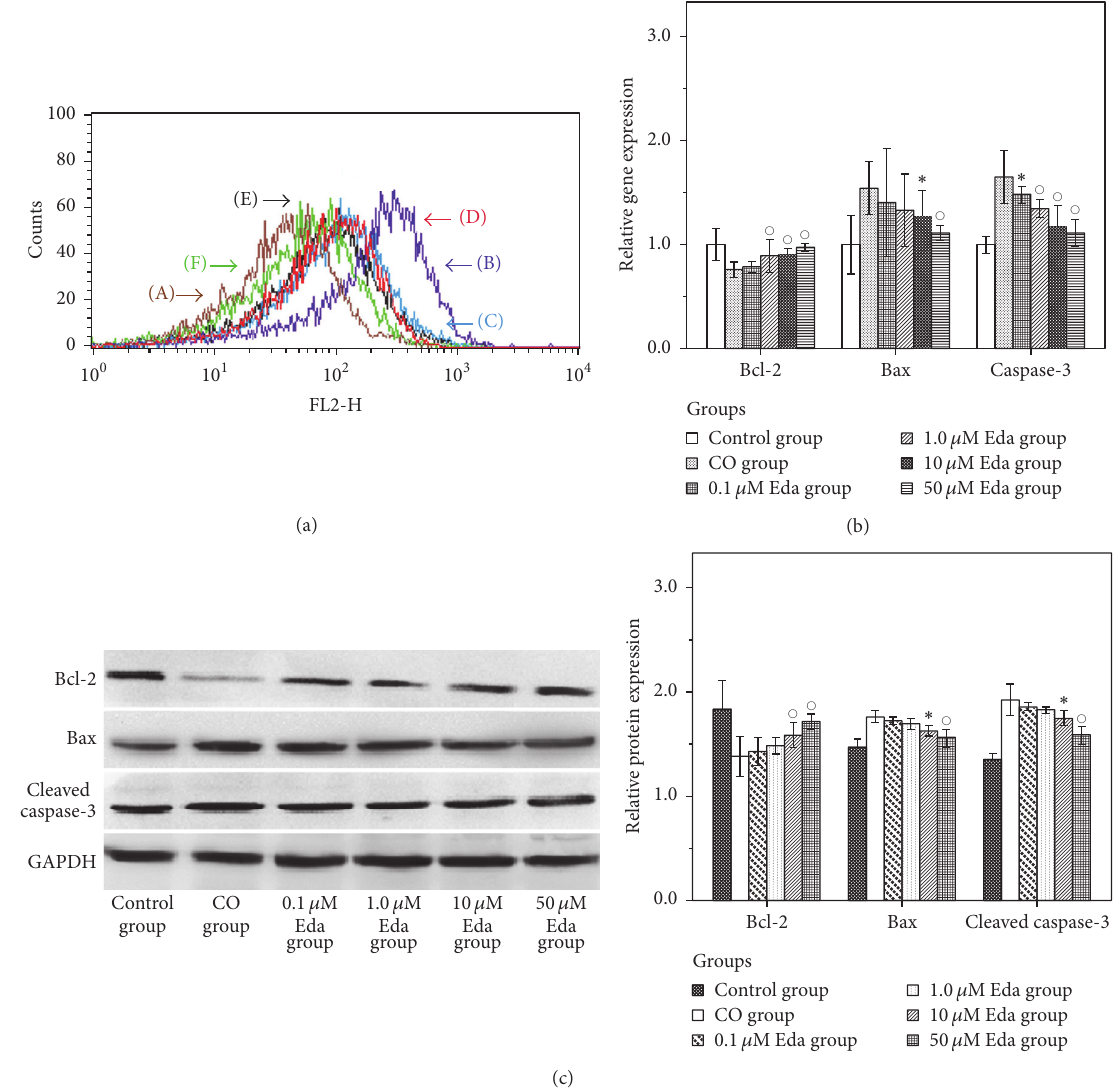
Figure 4: The results of ROS measurement, real-time PCR analysis, and Western blot analysis. (a) Cellular ROS level of each group was measured using FCM with DCFH-DA kit. (A) Control group, (B) CO group, (C) 0.1 𝜇 M Eda group, (D) 1.0 𝜇 M Eda group, (E) 10 𝜇 M Eda group, and (F) 50 𝜇 M Eda group. (b) The relative mRNA expressions of Bcl-2, Bax, and cleaved caspase-3 were estimated using real-time PCR analysis. Compared with CO group: ∗ 𝑃 < 0.05 , ∘ 𝑃 < 0.01 . (c) The protein expressions of Bcl-2, Bax, and caspase-3 were estimated using Western blot analysis. Compared with CO group: ∗ 𝑃 < 0.05 , ∘ 𝑃 < 0.01 . For each method, three biological replicates were prepared for each